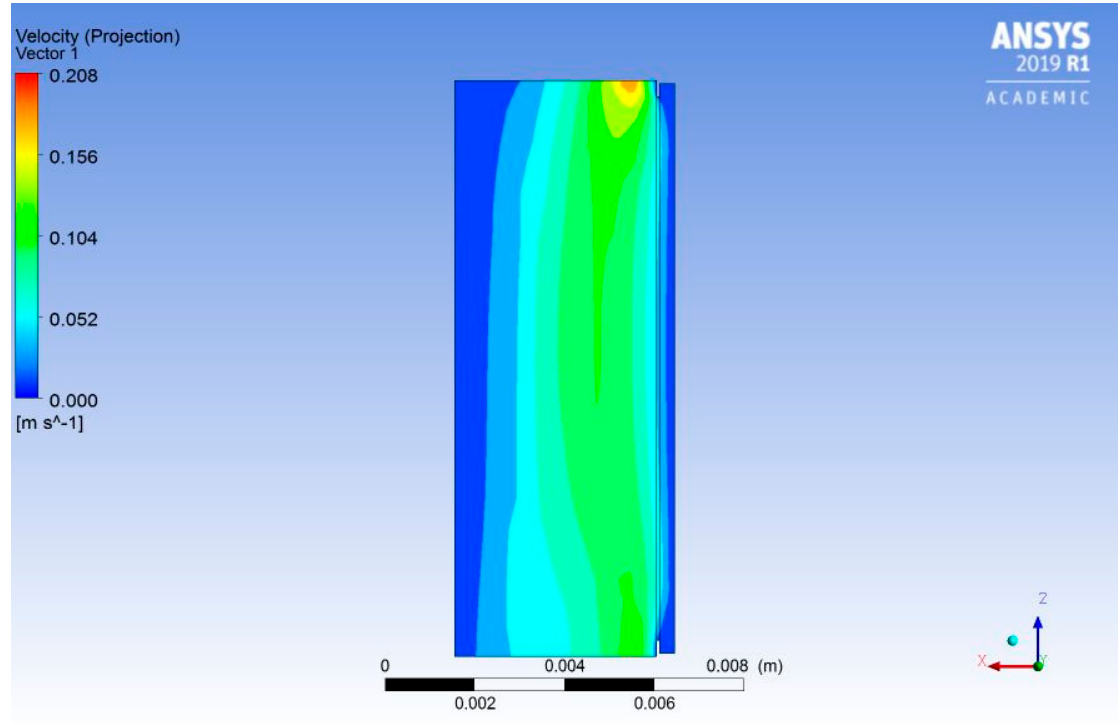
Figure 8. Velocity contours and streamlines of Duct-1, 50 cm width . Full turbulent flow from the second half of the duct’s height onward.